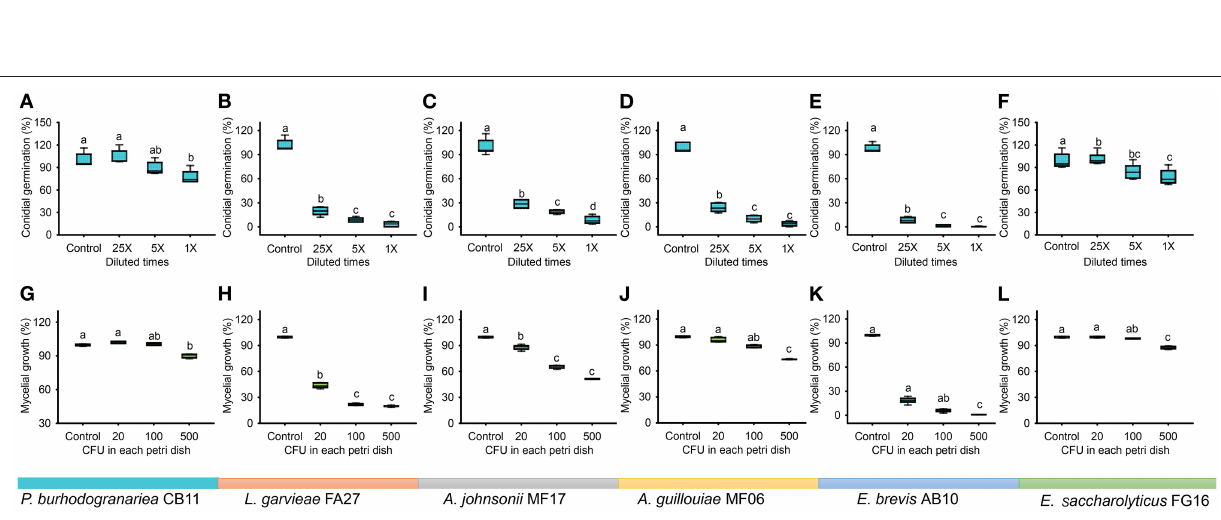
Frontiers in Microbiology |